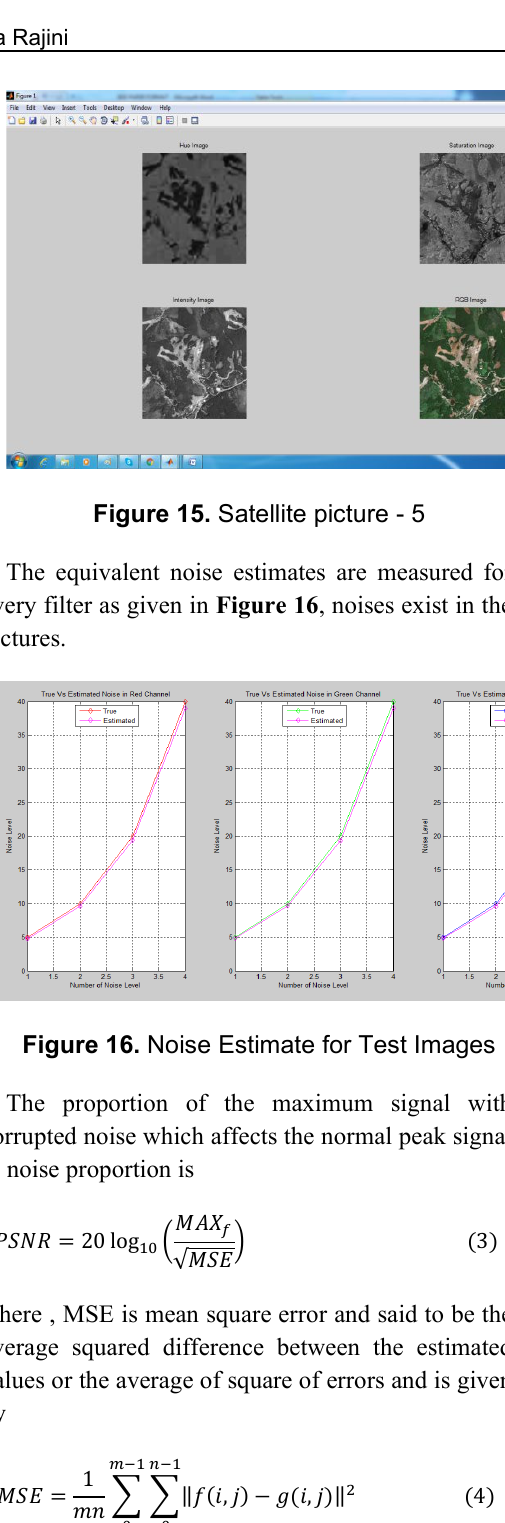
Figure 17. Reconstructed Pictures of Hybrid